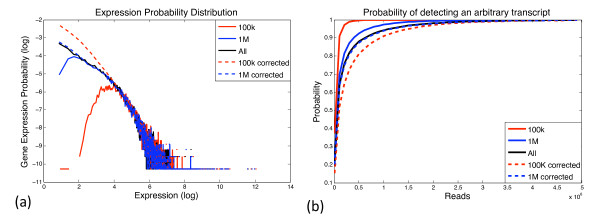
Transcript abundance distribution predicted from sampled reads. Figure 4: (a) Each point on a curve (solid-line) corresponds to the number of transcripts (Y-axis) that had a specific normalized count (X-axis). Note that the number of transcripts small counts relative to coverage drops sharply. For example, the curve for 100K drops at log(X) ≤ 5. This undersampling is corrected by the dotted lines. This correction enables the computation of (b), the probability of detecting an arbitrary transcript. The solid lines correspond to predictions made of the empirical (or simulated empirical) distribution. The dotted lines correspond to corrected values from regression (see METHODS). Note the high fit that is obtained after correction, with only 100,000 reads.